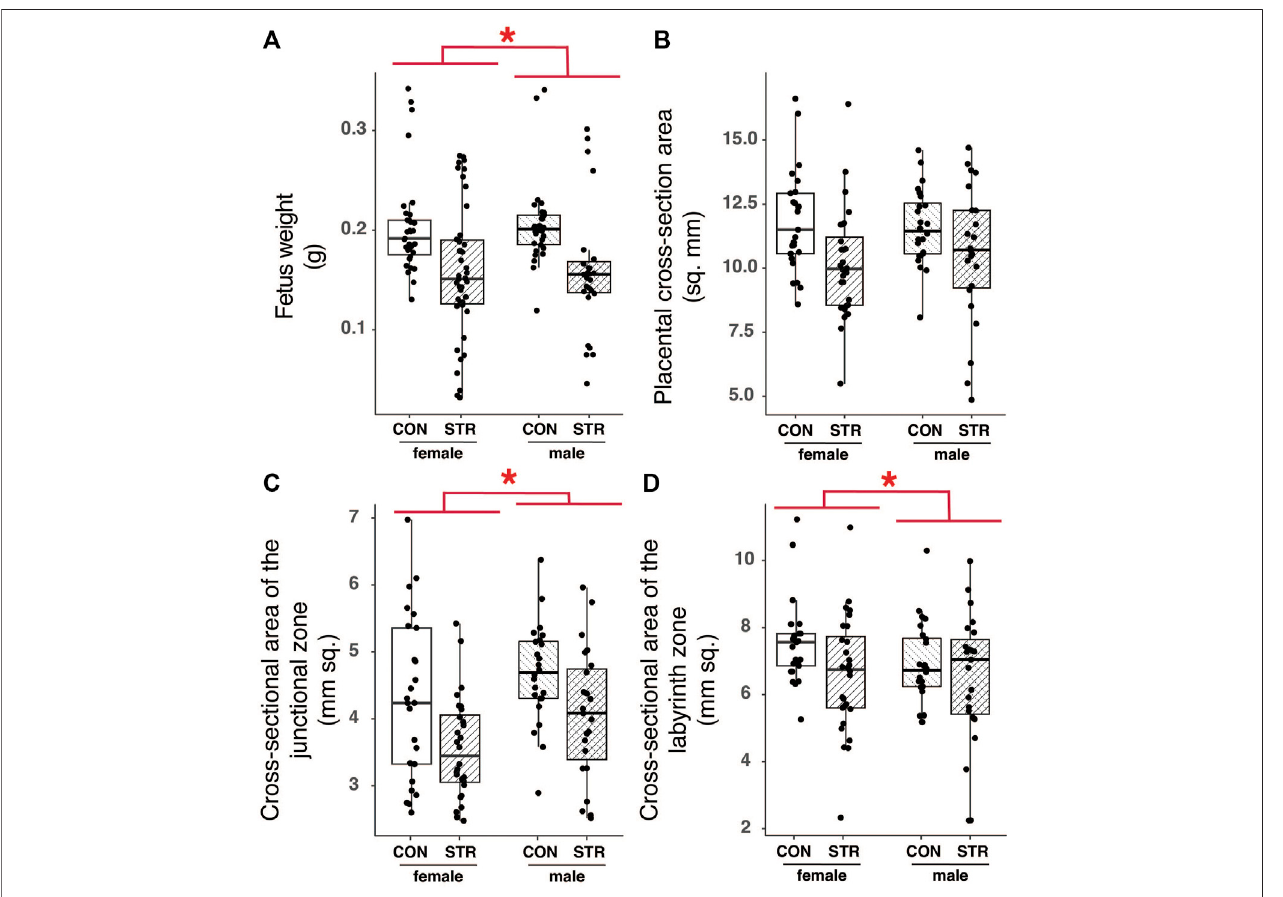
FIGURE 7 | Chronic psychological stress exposure did not affect fetal or placental outcomes. (A) Within litters, male embryos tended to be larger than female embryos,buttherewerenoeffectsofstressonmass. (B) Placentalcross-sectionalareasdidnotdifferbyfetalsexorwithgestationalstressexposure. (C) Theareaofthe junctional zone was larger in male embryos compared with female embryos, but it was not altered by gestational stress. (D) Female labyrinth zones tended to be larger than that of males, but there was no effect of gestational stress on the area. Letters indicate signi fi cant differences ( p < 0.05) in post-hoc analyses using the Bonferroni-Holm correction for multiple comparisons.